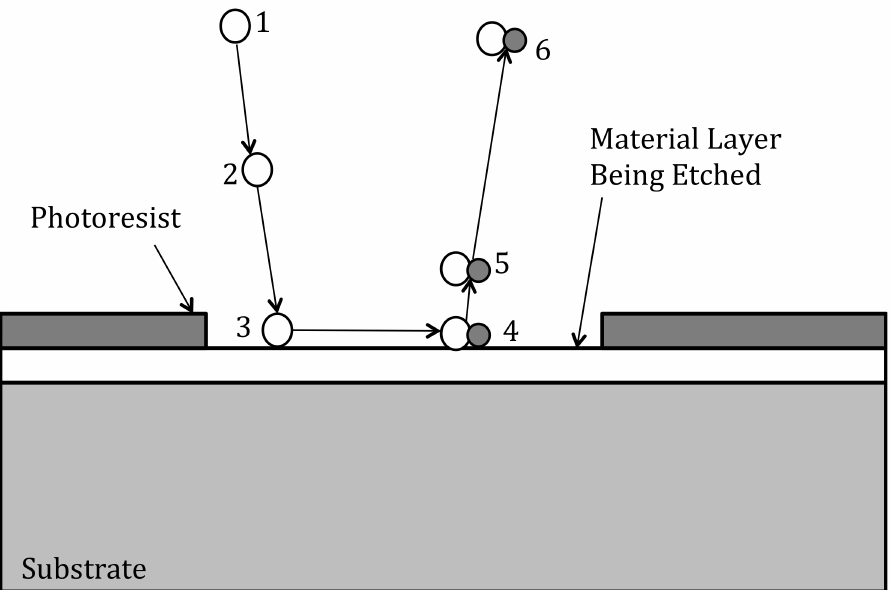
Figure 3. Illustration of the six steps involved in plasma etching [14]. Step 1: process gases are broken into chemically reactive species in plasma; Step 2: diffusion of reactive species to substrate surface; Step 3: absorption of reactive species onto material layer; Step 4: reaction between reactive species and material layer; Step 5: desorption of reaction by-products; Step 6: diffusion of